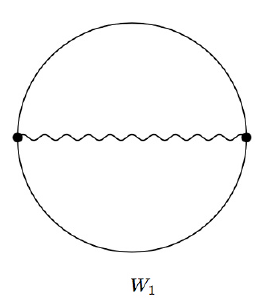
Figure 1 . Gauge (cid:12)eld exchange diagram contributing the standard Wilson loop at the leading order. In the Wilson-Maldacena loop case there is an additional scalar exchange